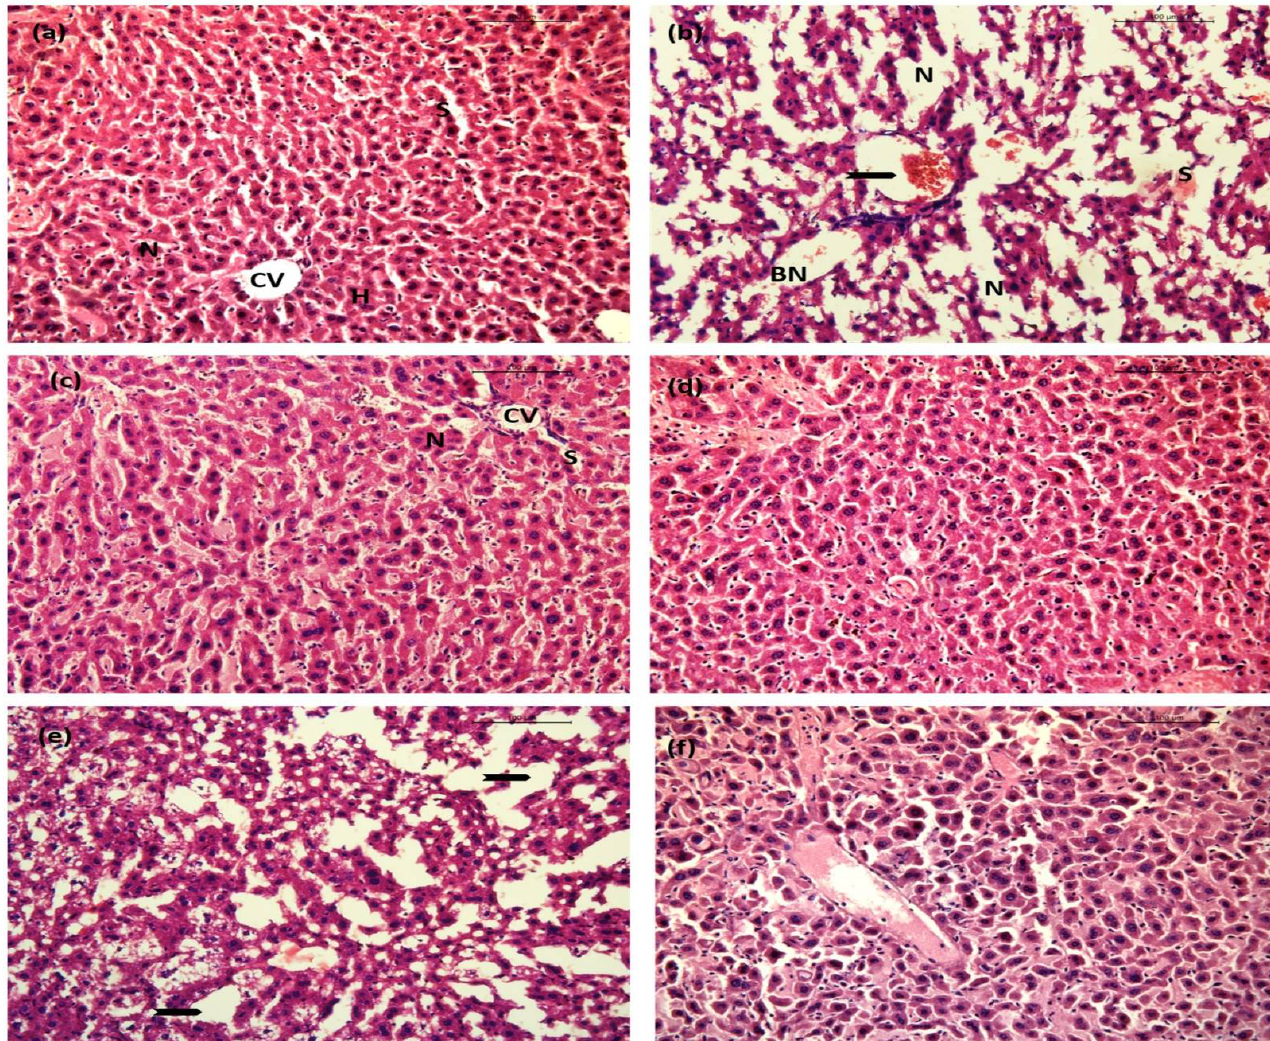
Figure 15. Images represent the BGG protection on LPS-induced sepsis model in mice. Hematoxylin and eosin (H&E)-stained liver. ( a ) Saline showing normal hepatic architecture with the central vein (CV) and surrounding hepatocytes (H), sinusoids (S), and nucleus (N). ( b ) Lipopolysaccharide (LPS) endotoxin showing hepatic mononuclear cell infiltration, congestion of central vein and hemorrhage (arrowhead) and blood sinusoids (S), binucleated hepatocytes (BN), necrotic area (N), congested blood sinusoids (S). ( c , d ) BGG 20 mg/kg and 40 mg/kg showing no significant pathological alter- ation. ( e ) LPS + BGG 20 showing moderate degeneration of hepatic architecture with necrotic areas (arrowhead). ( f ) LPS + BGG 40 indicating least necrotic and scarred areas with mild blood